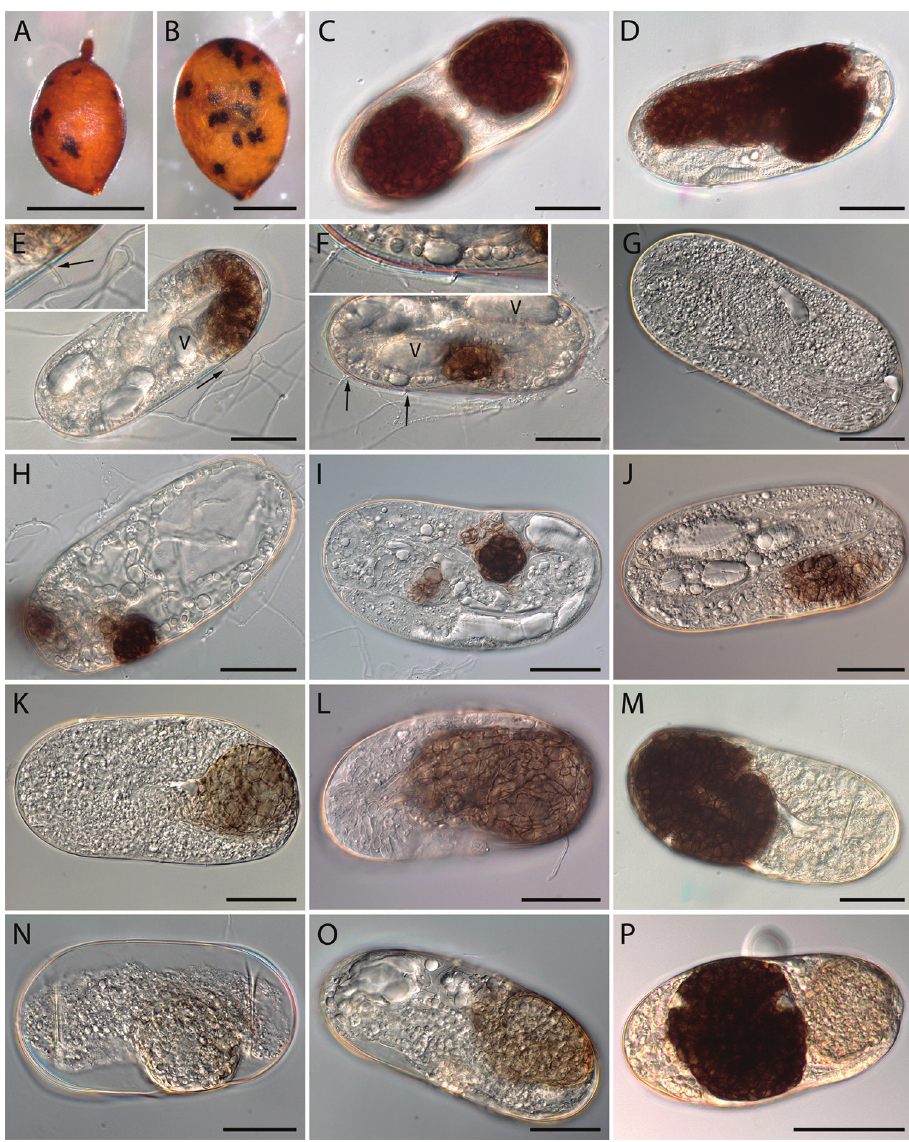
Figure 4. Cysts and eggs of Heterodera filipjevi infected by Monocillium gamsii exhibiting colonisation in vitro. A, B infected cysts rendered black-dotted due to fungal-colonised eggs containing microsclerotia C, D Eggs with mature sclerotia, extracted from symptomatic cysts E, F Individual hyphae penetrating eggshell (arrows indicate the individual hyphae; V indicates vacuole-like structures) G–M Fungal devel- opment inside the eggs G, H Earlier stages of infection in unembryonated eggs I, J Fungal development in the body cavity of developing juveniles where enlarged, thick-walled cells are formed and coalesce to initiate microsclerotia formation K–M Microsclerotia developing to full size and pigmentation N–P Pigmentation in microsclerotia from pale-olivaceous to darkly brown. Scale bars: 600 µm ( A ); 300 µm ( B ); 30 µm ( C–O ); 50 µm ( P